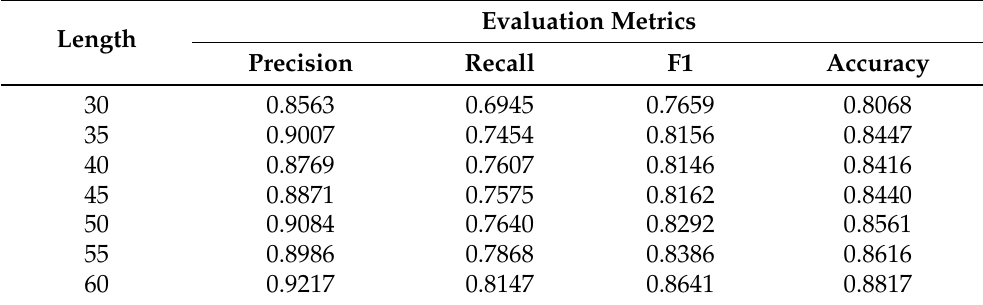
Table 2. Comparison of experimental results on the prediction of lightning occurrence time by different lengths of electric field time series.